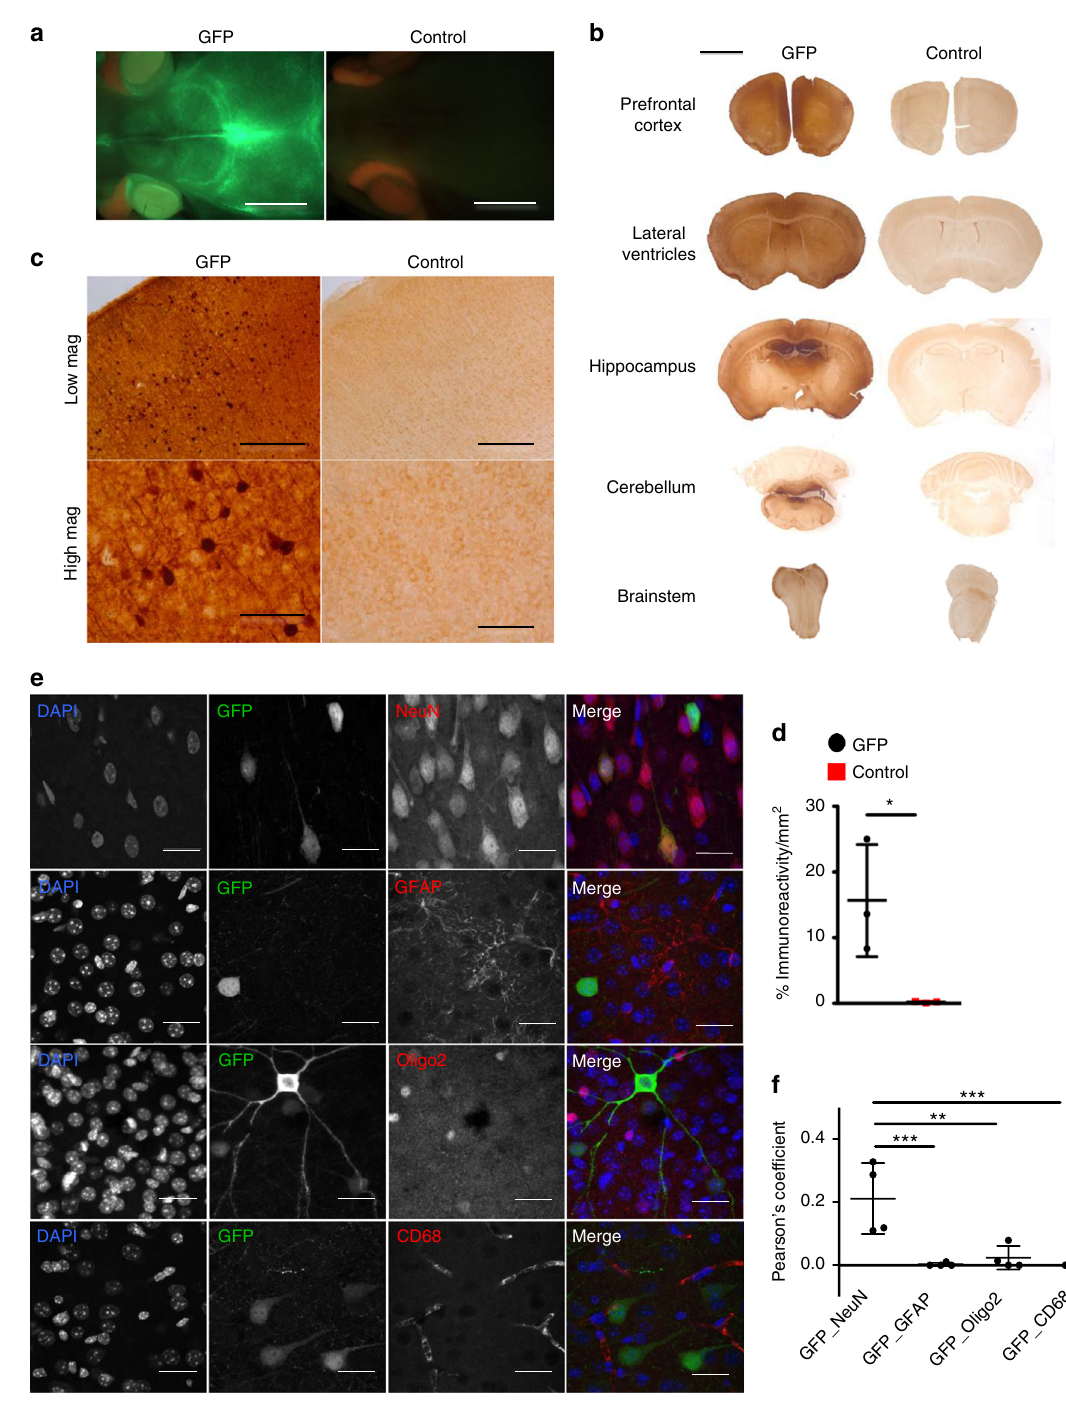
Fig. 2 Neonatal intravenous injection of AAV8.EFS.GFP enables neuronal transduction. a Brain imaged with fl uorescence microscope in CD-1 pups injected intravenously with AAV8.EFS. GFP (GFP) and uninjected controls. b , c Representative images of GFP immunostaining in brain at b low and c at higher magni fi cations in mice injected with the GFP vector and uninjected controls show a decreasing rostro-caudal gradient with preferential transduction of forebrain and midbrain. d Computational quanti fi cation of GFP immunostaining showed a signi fi cant increase in AAV8.EFS. GFP -injected versus uninjected littermates ( n = 4). e Immuno fl uorescence of cortical staining for DAPI (blue), GFP (green), and NeuN, GFAP, Olig-2, CD68 (red) identifying neurons, astrocytes, oligodendrocytes and microglial cells, respectively. f Colocalisation measured by Pearson ’ s coef fi cient showed a restricted neuronal transduction. Horizontal lines display the mean ± SEM. d Unpaired two-tailed Student ’ s t test * p < 0.05. f One-way ANOVA with Dunnett ’ s post-test compared to GFP_NeuN ** p < 0.01, *** p < 0.001. Scale bars: a , b 5 mm; c 500 μ m and 125 μ m in low and high magni fi cation pictures, respectively; e 25 μ m. Figures show representative images and e representative z-projections for GFP-NeuN and GFP-Olig-2 of four animals. GFP green fl uorescent